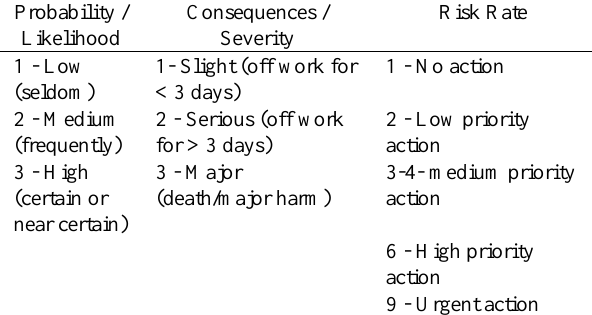
Figure 4. With respect to HS risks, relevant to terrain, are determined by spatial terrain analysis. Therefore it is based on raster data and its derived forms like height and slope data. Table1. Probability, consequence and risk rate values used in Derived raster data and its source shown on Figure the risk matrix